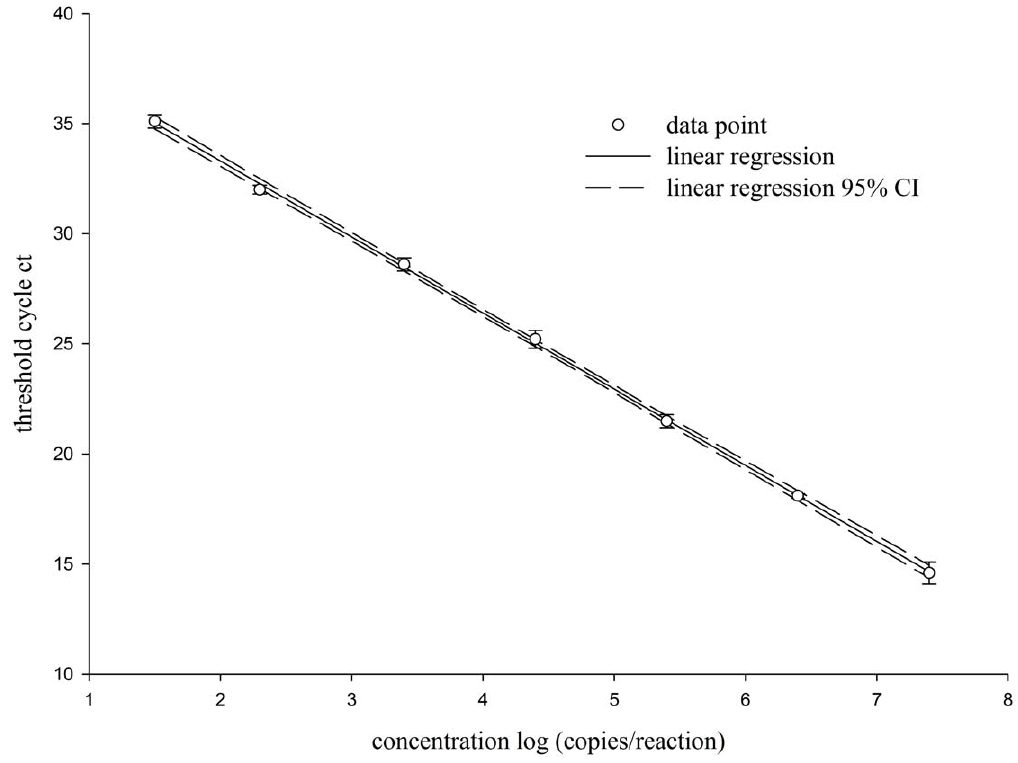
Figure 4. Standard curve obtained by the competitive reporter monitored amplification method. Samples with a known amount of target template have been used to establish a standard curve. The amount of target is given as logarithmic copy numbers as indicated in the graph. The threshold cycle values are plotted against the logarithm of the initial amount of target template copies. The curve function has been determined as C t = 2 3.55*log (copy numbers) + 39.73 (r=0.999, P , 0.001). The amplification efficiency is calculated to be 92%.